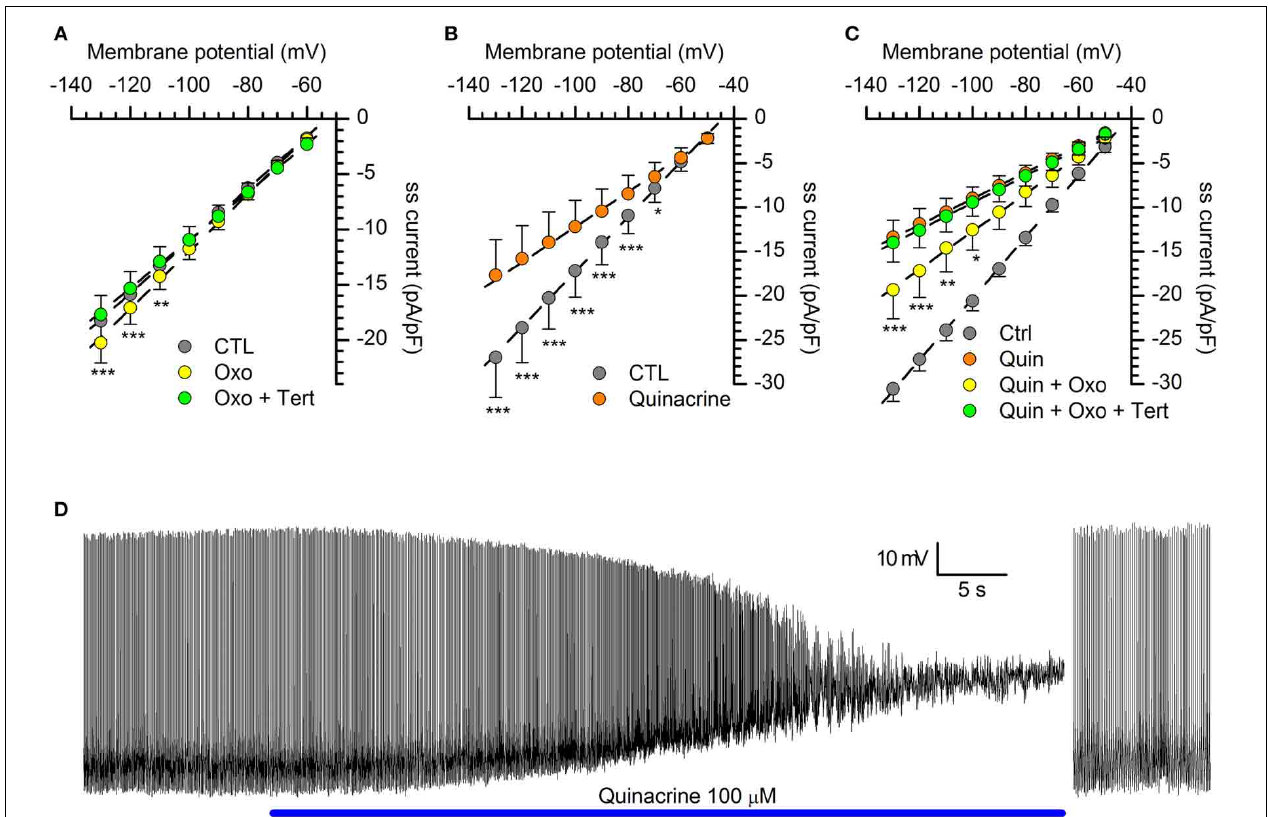
FIGURE 7 | Organic blockers of the K ir channels. (A) with a GIRK current activated by a cholinergic muscarinic agonist (oxotremorine 10 μ M), the GIRK channels blocker tertiapin-Q (1 μ M) completely suppresses the current ( n = 11; see text for explanation); tertiapin-Q alone does not change the amplitude of hyperpolarization-activated (not shown; n = 13). In this as in the following panels, the steady-state (ss) current is calculated in relation to membrane capacity. (B) Quinacrine (100 μ M) inhibition of hyperpolarization-activated current ( n = 15). (C) With the KIR2.x channels blocked by quinacrine, a muscarinic cholinergic agonist (oxotremorine 10 μ M)